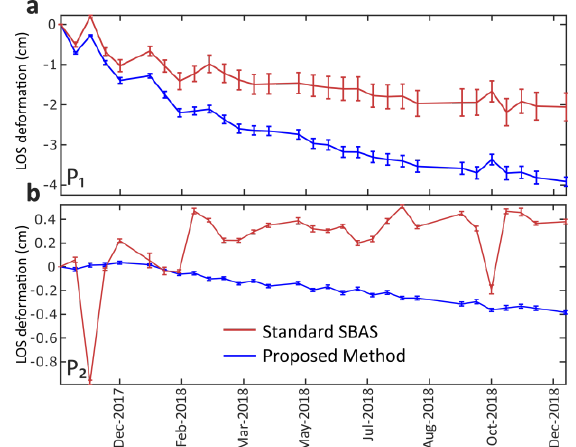
Figure 5. Time series plots illustrating the time-dependent evolution of postseismic deformation on points P1 (a) and P2 (b), which are depicted in Fig. 3b.